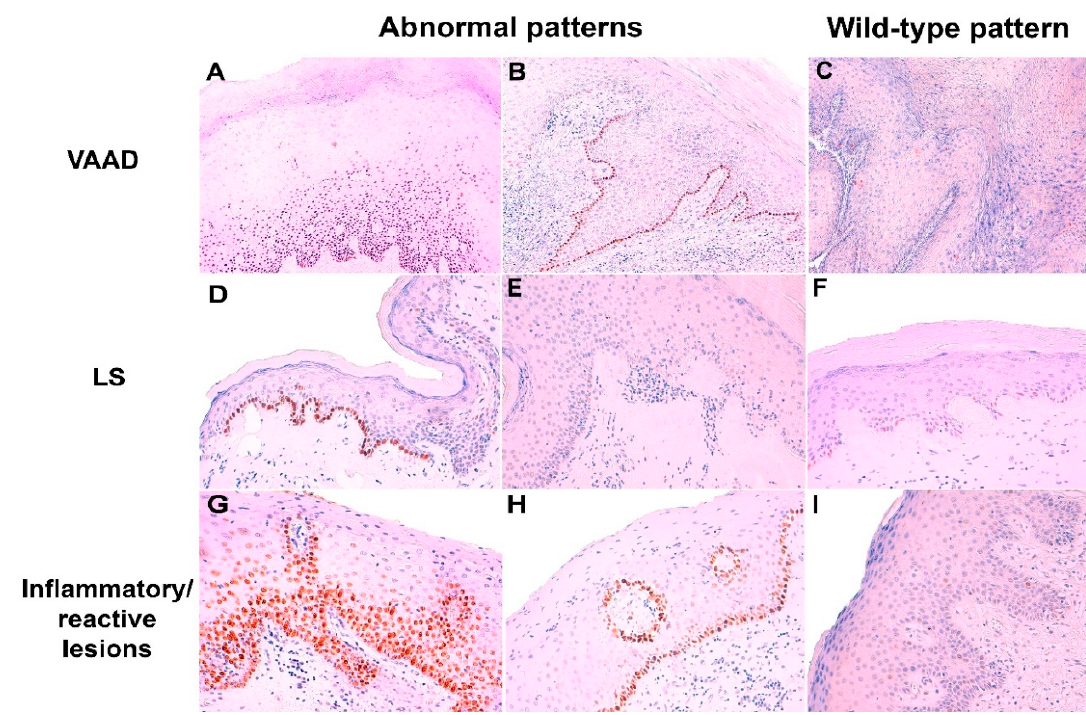
Figure 2. Examples of abnormal and wild-type p53 immunohistochemical expression in vulvar acanthosis with altered differentiation (VAAD), lichen sclerosus (LS) and inflammatory/reactive lesions. ( A , G ) Parabasal/diffuse patterns; ( B , D , H ) basal pattern; ( E ) null pattern (with wild-type staining in the hair follicle on the left); ( C , F , I ) wild-type scattered staining. (p53 IHC immunostaining with hematoxylin counterstain, original magnification: 100×).